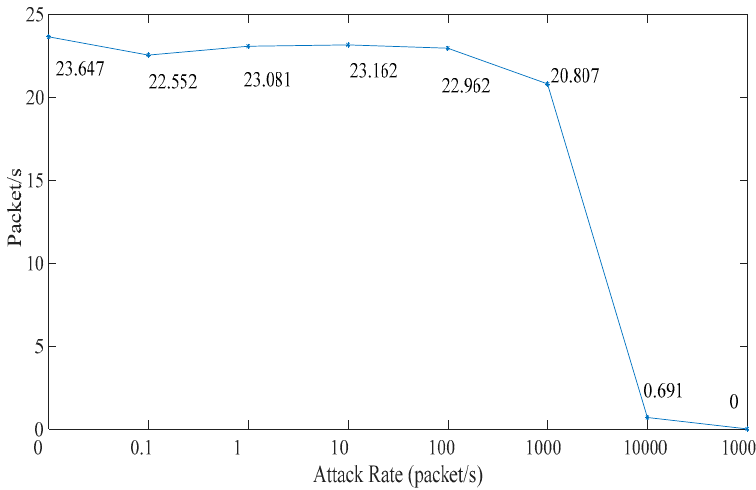
Figure 10. Test packet number per-second under different DoS attack rates.